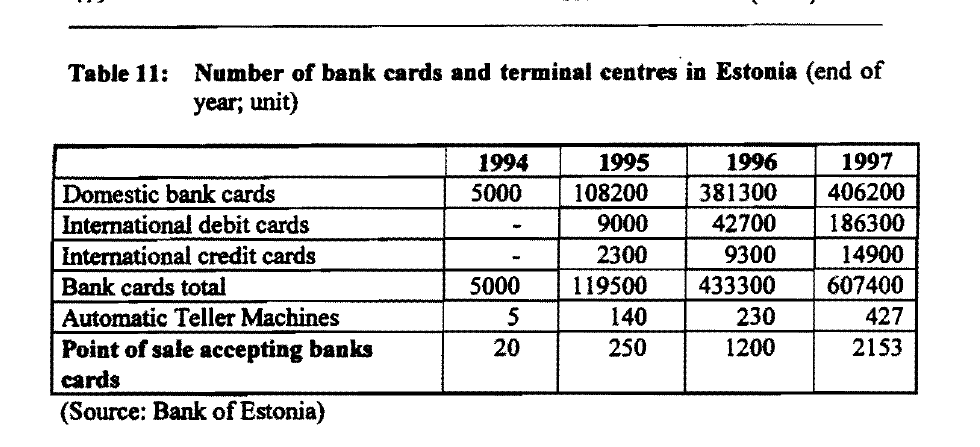
Number of bank ards and terminal centres'in Estonia (end of year; unit) 1994